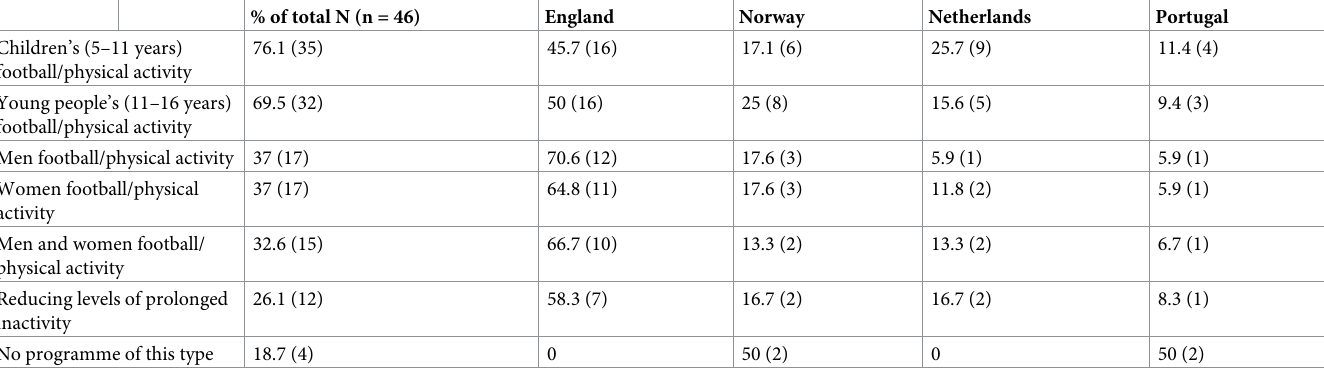
Table 2. Frequency of physical activity programs delivered in professional football clubs in four European countries. % of total N (n =